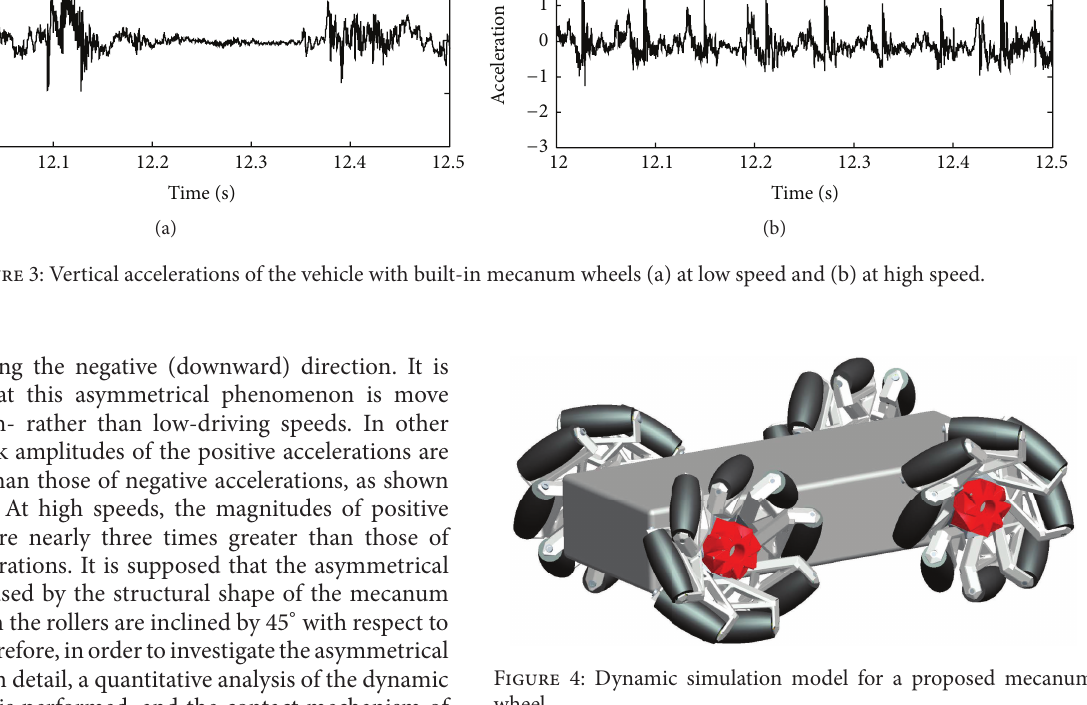
Figure 4: Dynamic simulation model for a proposed mecanum